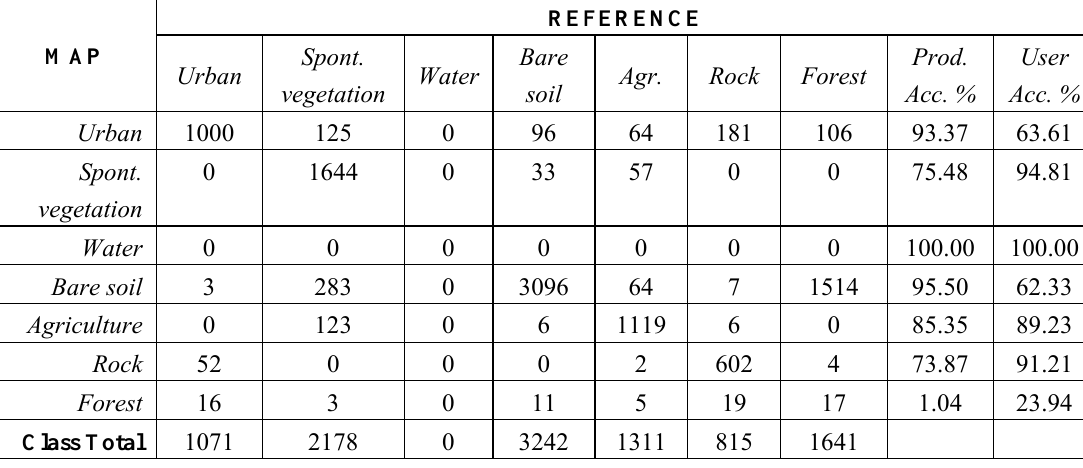
Table 5. Error matrix of the accuracy on the 2007 change areas. MAP